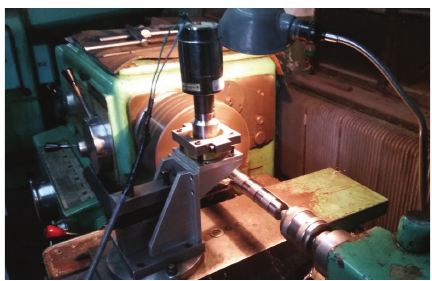
Figure 9: Photograph of experimental setup.